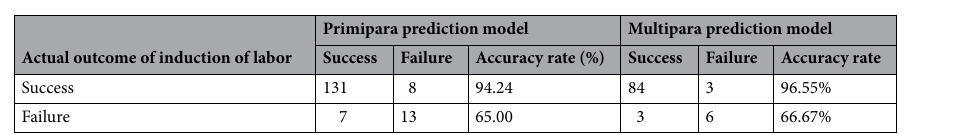
Figure 2. ROC curves of logistic regression model of primiparas and multiparas.